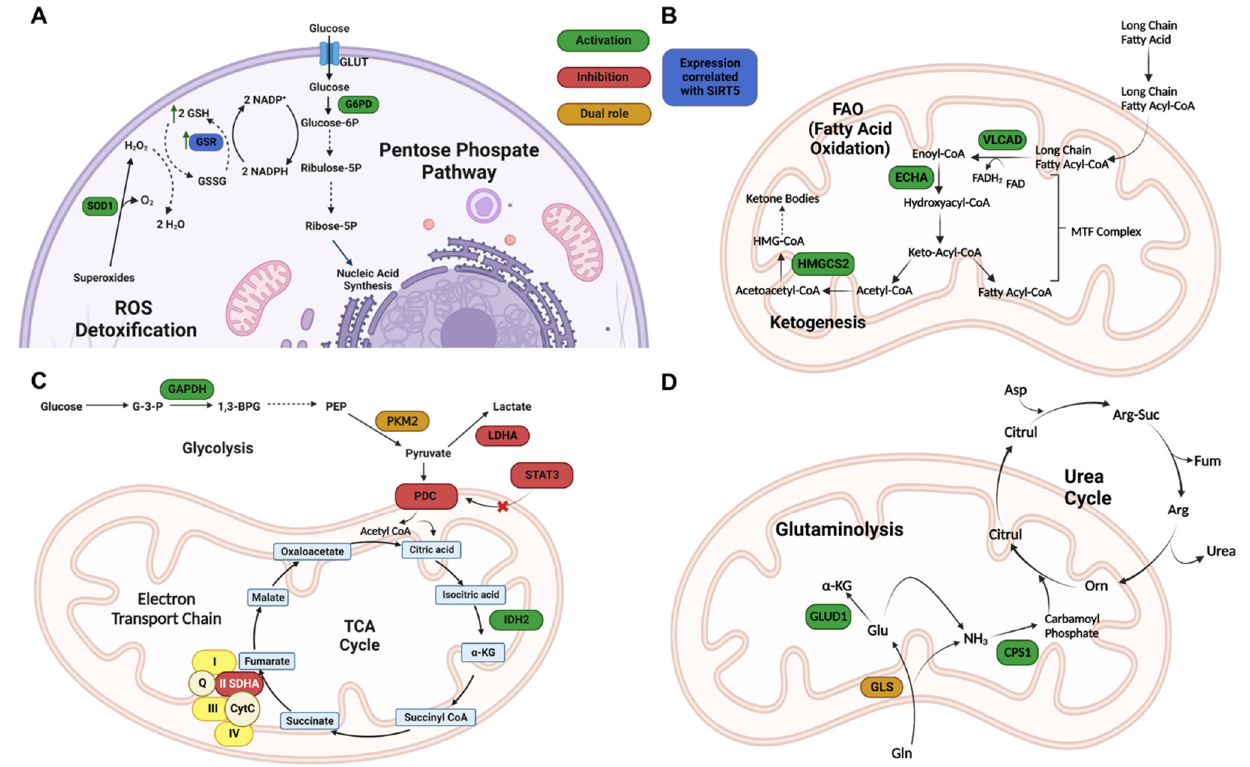
Figure 3. Redox homeostasis and metabolism regulation by SIRT5. ( A ) SIRT5 modulation of ROS detoxification enzymes. G6PD—glucose ‐ 6 ‐ phosphate dehydrogenase; GSH—reduced glutathione;